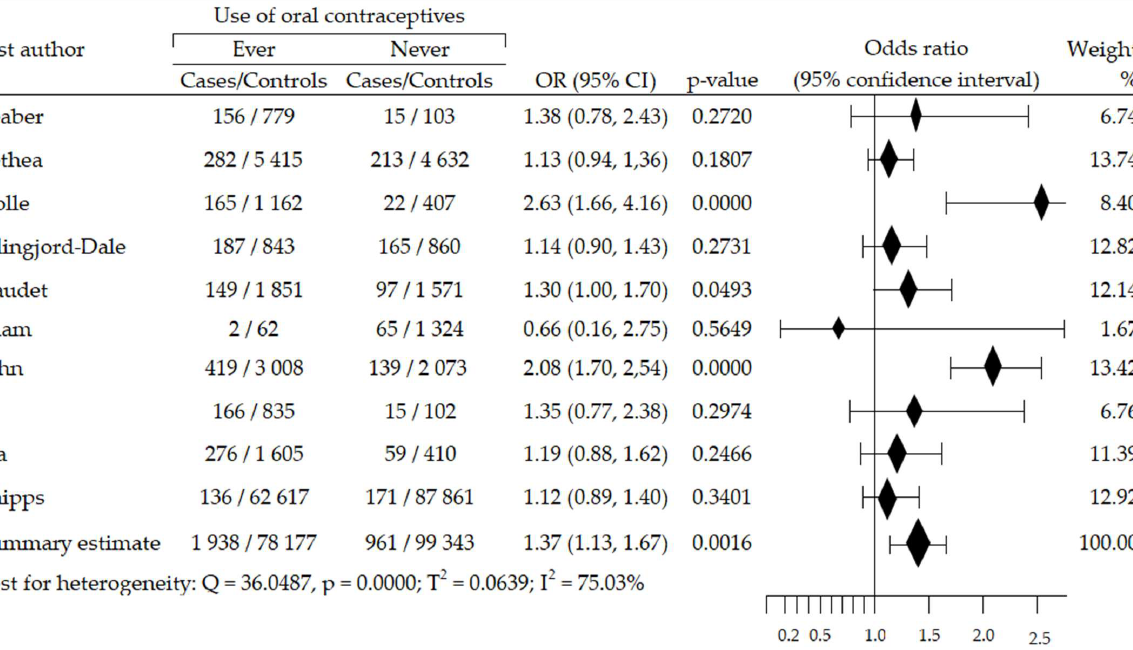
Figure 5. Forest plot and summary odds ratios on the association between risk of TNBrCa and ever-use of oral contraceptives. Note: black diamonds represent the effect sizes; the horizontal lines denote the 95% confidence interval.